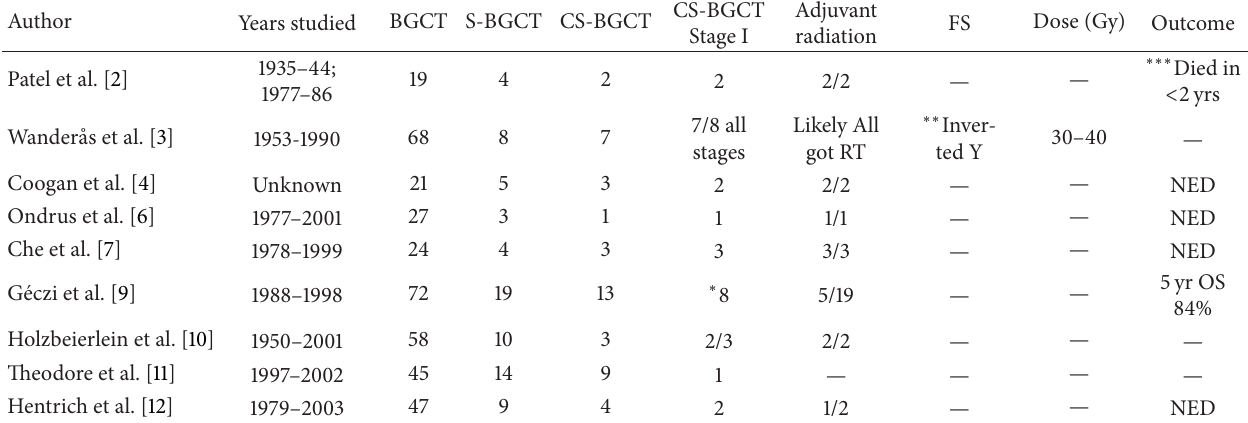
Table 2: Select series, incidence of BGCT and synchronous stage I seminomas, therapy, and outcomes.